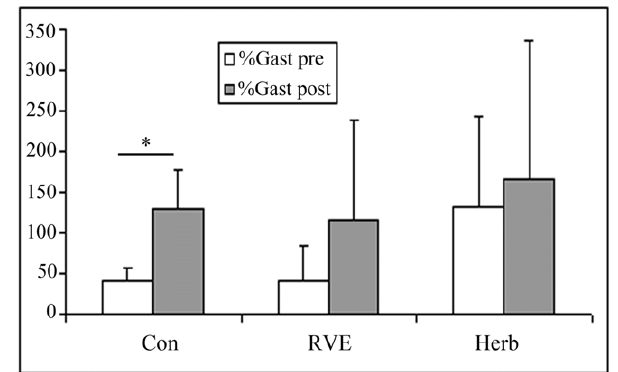
Figure 7. Percentage changes in gastrocnemius (GAST) section from supine to tilt positions. Gast section was measured by echography as detailed in the Materials and Methods section. The percent change in Gast section from supine to tilt positions was increased more post-HDBR in the Con gr. RVE and Herb contributed to limit Gast distension, with the effect of Herb being greater.